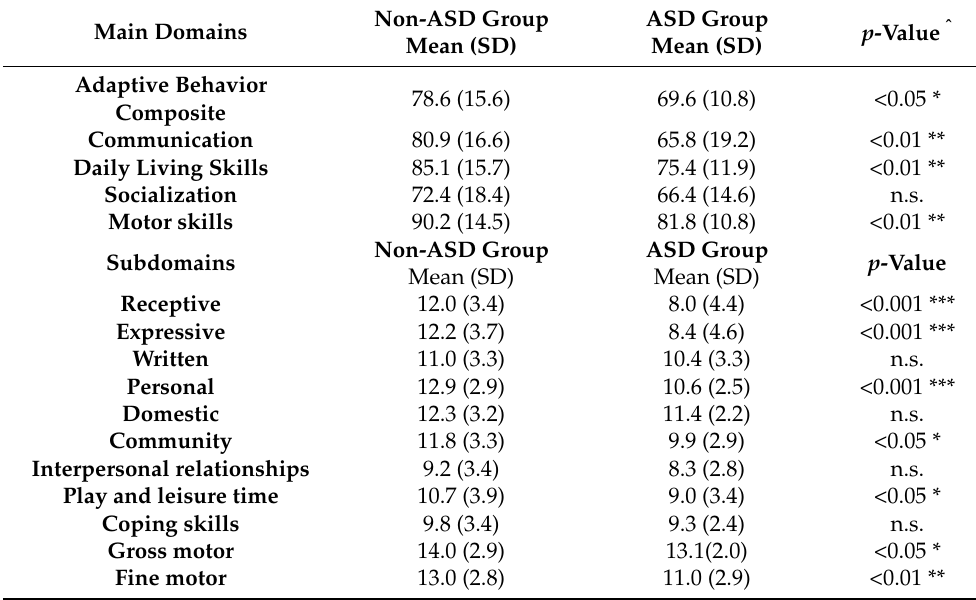
Table 3. Adaptive behavior profile (main domains and subdomains) in ASD and non-ASD participat- ing